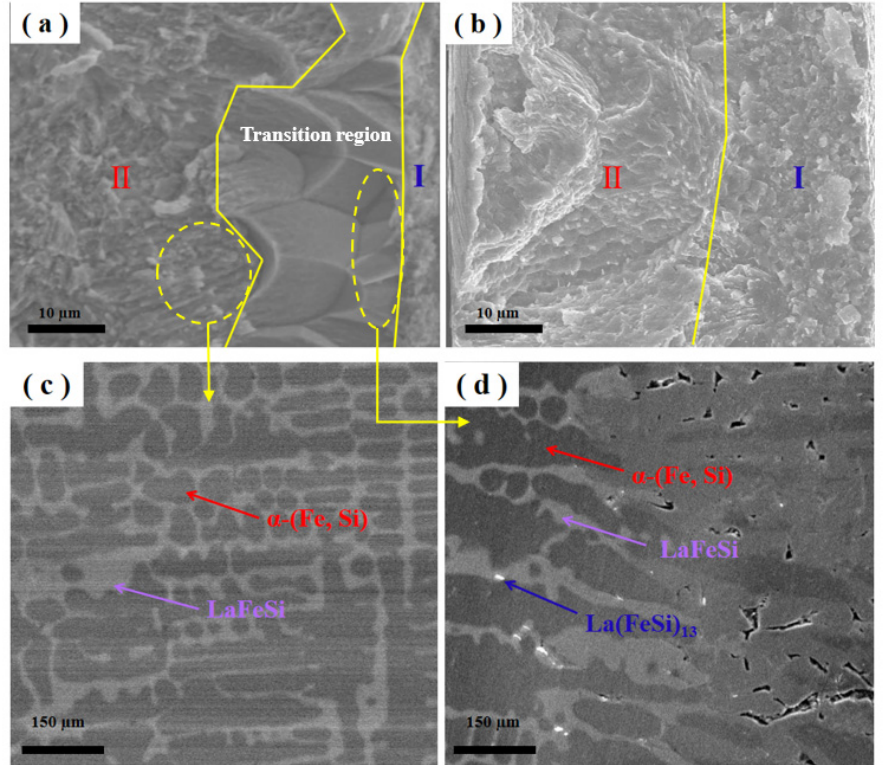
Figure 2. SEM images of a melt-spun La-Fe-Si ribbon ( a , b ) cross-sectional images of a melt-spun LaFe 11.5 Si 1.5 C x (x =0, 0.2) ribbons; ( c ) Magnification of region Ⅱ ; ( d ) Magnification of the transition LaFe 11.5 Si 1.5 C x (x = 0, 0.2) ribbons; ( c ) Magnification of region II; ( d ) Magnification of the transition region.